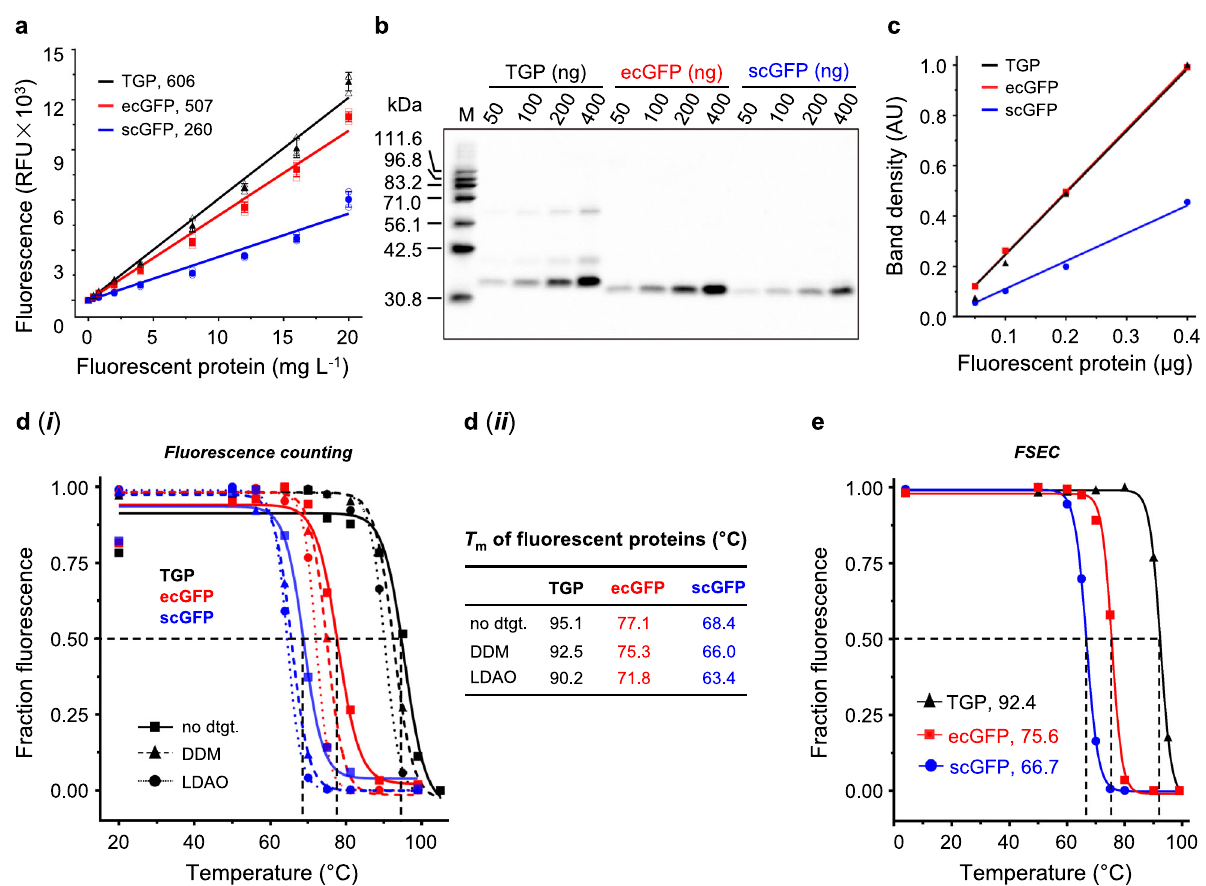
Fig. 1 TGP was brighter and more stable than GFPs. a Linear correlation between fl uorescence (in a relative unit, RFU) and concentration (in a 0.2-mL solution) with indicated slope (RFU for 1 mg L − 1 of fl uorescent protein). Mean and standard deviation of three independent experiments are plotted. b In- gel fl uorescence image with inverted colors. M: home-made fl uorescent markers 14 . Data are representative of two independent experiments. c Linear correlation between integrated in-gel fl uorescence (in an arbitrary unit, AU) and loading using data in b . d Fluorescence counting-based melting curve ( i ) and T m value ( ii ) of the fl uorescent proteins in the absence or presence of indicated detergents (dtgt). Data are from a single experiment. e FSEC-based melting curve of the fl uorescent proteins in the presence of dodecylmaltoside. Graph depicts mean of three technical replicates. The unit (°C) for T m is omitted for all panels. In this report, all samples were heated for 20 min for T m measurement unless stated otherwise. In panels a , c , and e , black triangle denotes TGP, red square denote ecGFP, and blue circle denotes scGFP. In d , TGP traces are black, ecGFP traces are red, and scGFP traces are blue; Solid line with square denotes samples without detergents, dashed line with triangle denotes DDM samples, and dotted line with circle denote LDAO samples. DDM dodecylmaltoside, FSEC fl uorescence-detection size exclusion chromatography, GFP green fl uorescent protein, LDAO lauryldimethylamine oxide, TGP thermostable GFP, T m melting